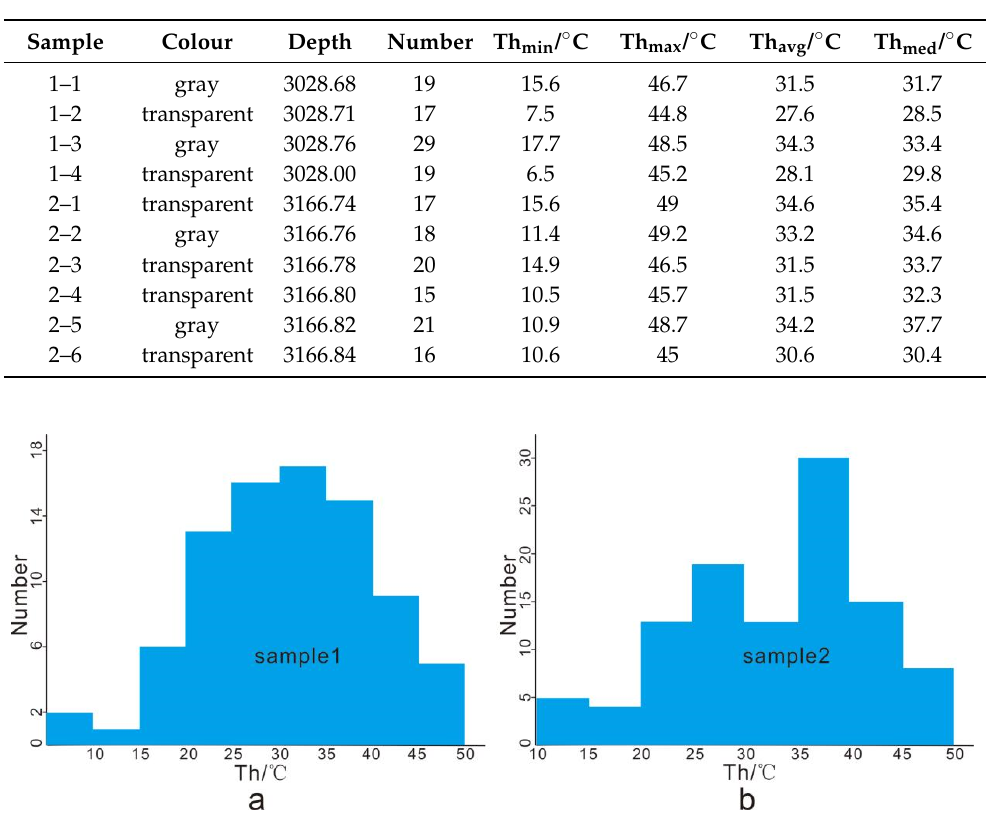
Figure 5. Th histogram of halite inclusions of the studied core S1.